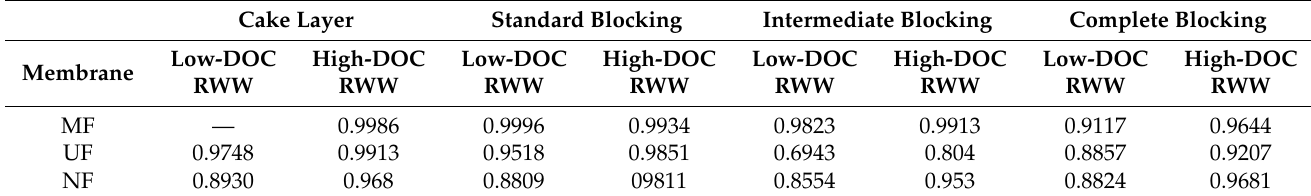
Table 4. R 2 of single model fitting for gradient filtration of